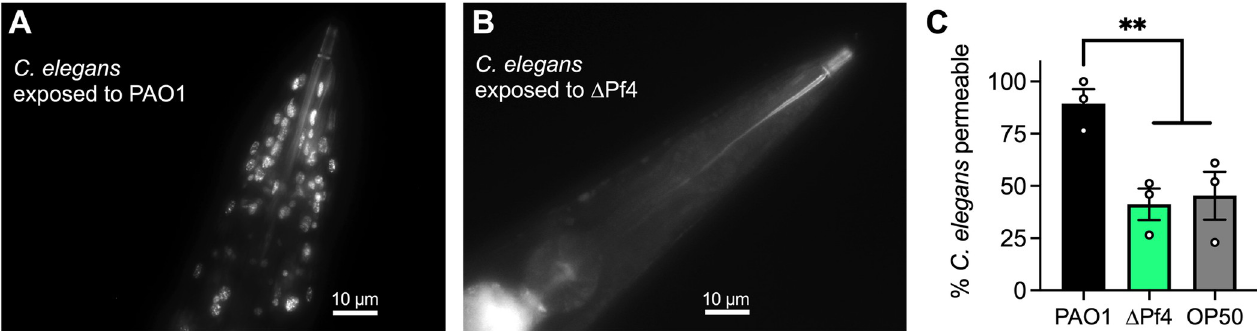
Fig 5. PAO1 compromises C . elegans cuticle integrity compared to Δ Pf4. Synchronized young adult N2 worms were collected from lawns of PAO1, Δ Pf4, or E . coli OP50 after 48 hours and stained with the nucleic acid stain Hoechst. Cuticle permeability was assessed by visualization of stained nuclei in live nematodes exposed to (A) PAO1 or (B) Δ Pf4. Representative images are shown. (C) The percent C . elegans with stained nuclei were scored as permeable and plotted. �� P < 0.01, Student’s t -test. N = 3 replicates of 25–50 animals per replicate, 92–137 total worms per group.